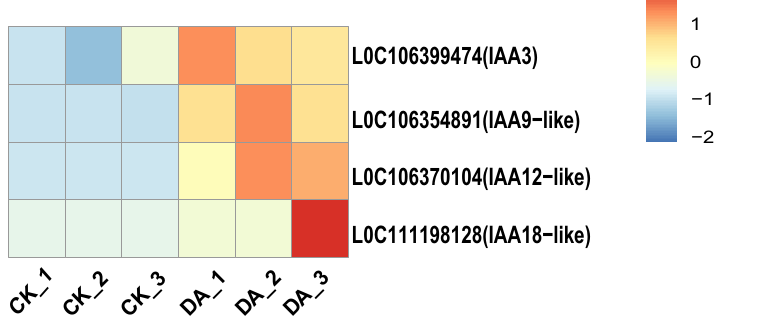
Figure 3. The heat map of plant hormone gene expression in B. napus between control (CK) and HT-COS (DA) treatments.